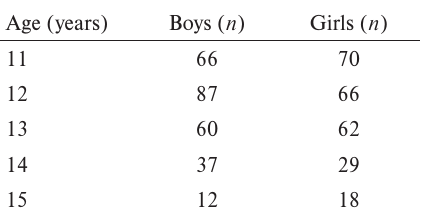
Numerical and descriptive data of participants (N =